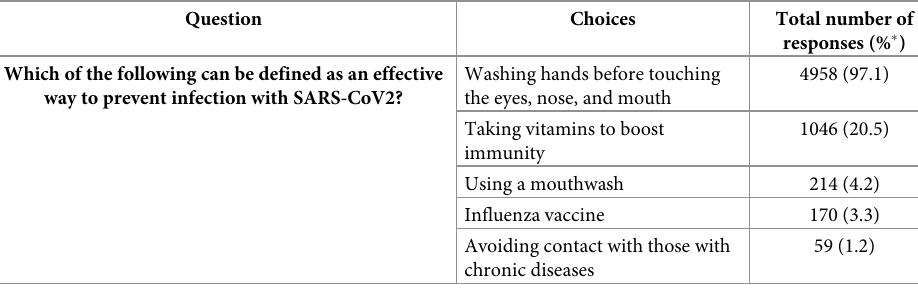
Avoiding contact with those with chronic